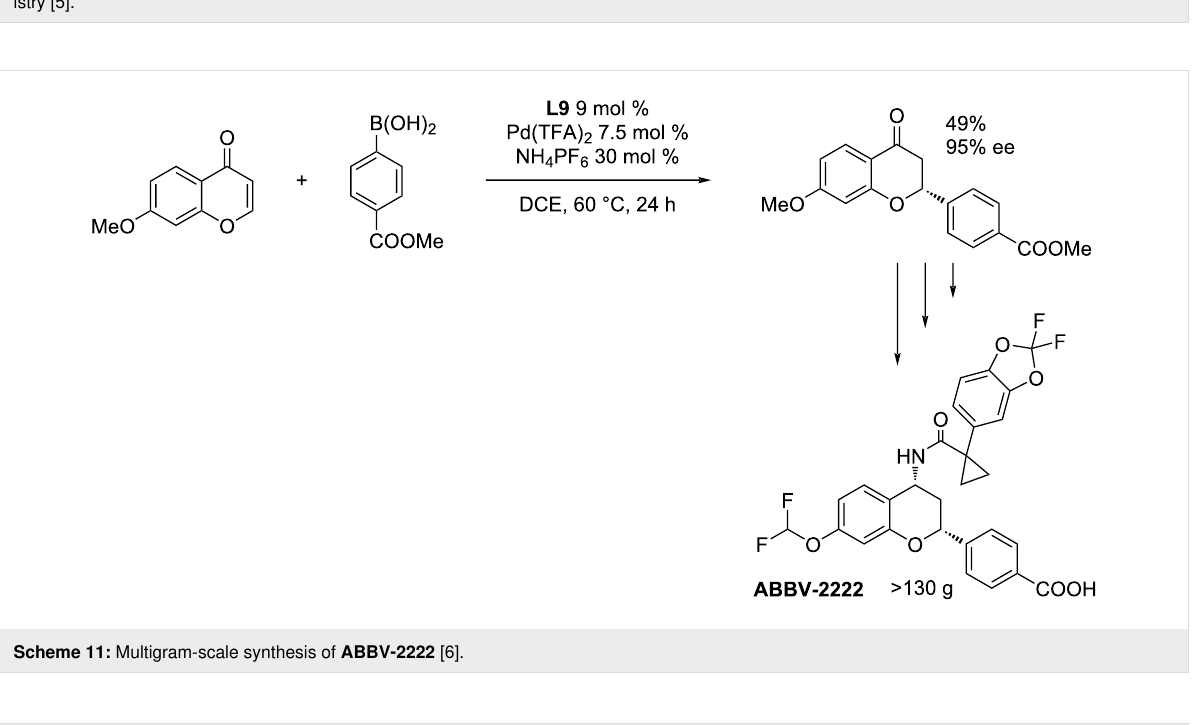
Table 24: Addition reactions of arylboronic acids to substituted chromones catalysed by L9 /Pd(TFA) 2 [7].